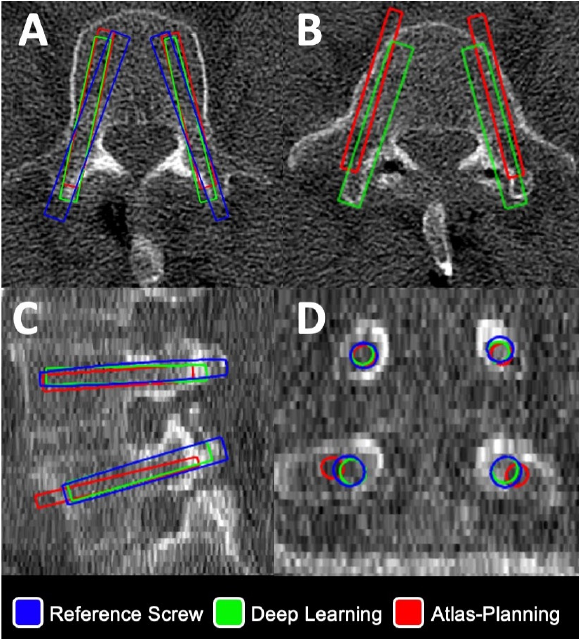
Figure 4. Illustration of virtual screw planning and evaluation for a L4 + L5 instrumentation in axial ( A , B ), sagittal ( C ) and coronal ( D ) planes in a category I case with normal vertebra anatomy. Note an anterior screw breach in atlas-based planning ( B , C ). Deviations of screw head and tip points and angular deviation were automatically calculated in Python for deep-learning-(green outline) and atlas-based screws (red outline) vs. corresponding reference screws (blue outline), respectively.